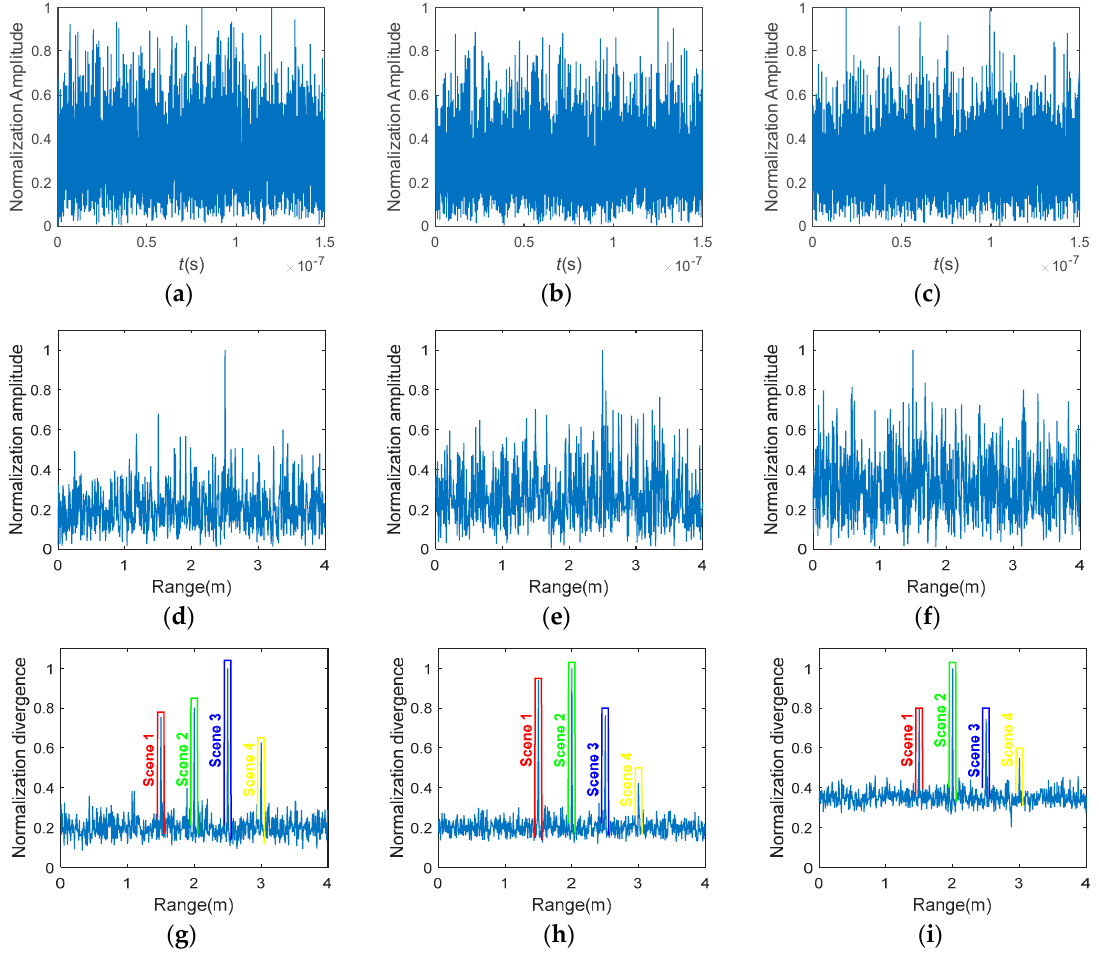
Figure 5. ( a – c ) The back signals at − 15 dB, − 20 dB, and − 25 dB, respectively; ( d – f ) the range profiles with pulse compression at − 15 dB, − 20 dB, and − 25 dB, respectively; ( g – i ) the range profiles processed with GMs at − 15 dB, − 20 dB, and − 25 dB, respectively.